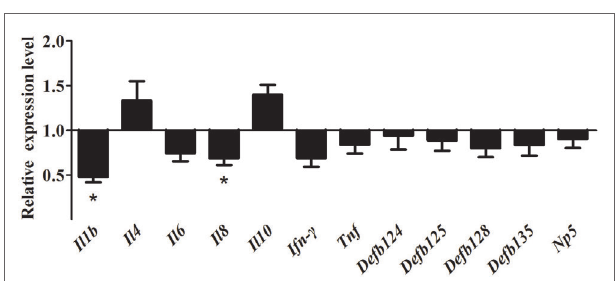
FigUre 7 | Effect of the overexpression of rabbit nucleotide-binding oligomerization domain 1 (rNOD1) on the expression of immune-related genes induced by Escherichia coli after inhibition of nuclear factor (NF)- κ B. pC-rNOD1 or pCDNA3.1-empty were transfected into cells for 24 h. Cells were pretreated with 10 µM of BAY11 - 7082 for 12 h to inhibit NF- κ B pathways and infected with E. coli. M ± SD from three independent experiments are presented. Significant differences are indicated by